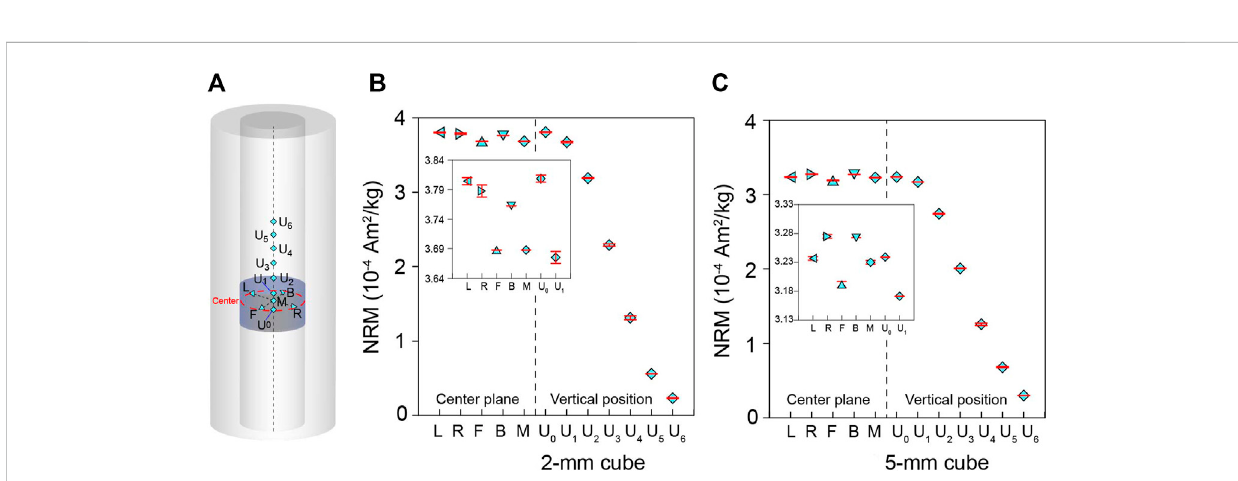
FIGURE 4 (A) SketchmapofNRMmeasurementposition.Thedistancebetweencentralpositionandeveryendpointoftwoorthogonallinesisabout8 mmfor the2-mmcubesandabout6 mmforthe5-mmcubes.Themeasurementintervalforverticalpositionsis1 cm.MeanNRMofa2-mmbasaltcube (B) and 5-mmbasaltcube (C) anditsstandarddeviationatdifferentpositions.Insertsin (B) and (C) areampli fi edresultsofpositionsinthedesignedmeasurement region of the